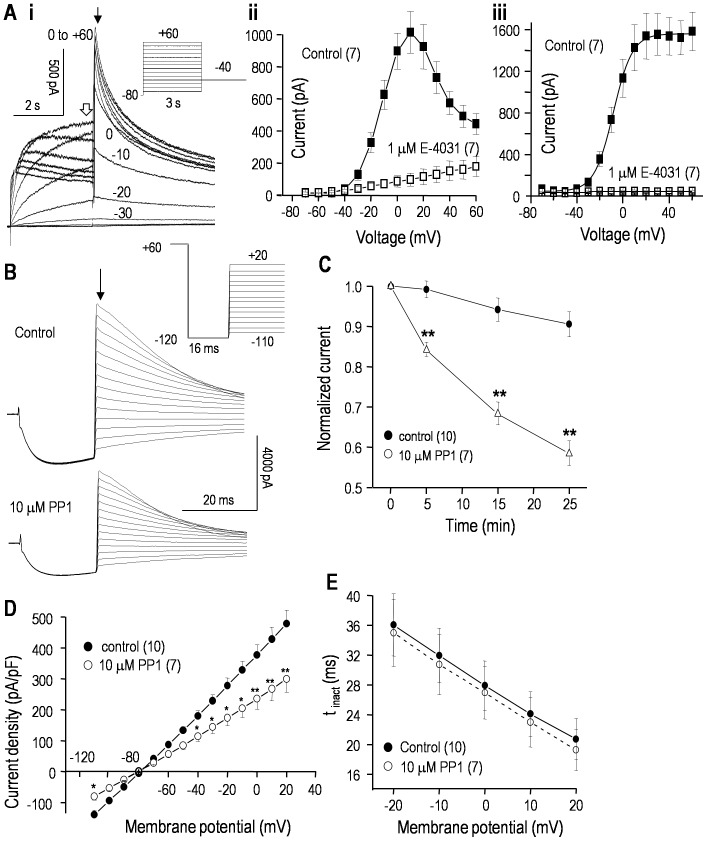
The hERG current in stably transfected HEK293 cells is reduced by the Src-family tyrosine kinase inhibitor, PP1.
A. i. Representative current traces in response to the voltage-clamp protocol shown in the inset. From the holding potential of −80 mV, 3-s long depolarizing steps were applied between −70 and +60 mV (10-mV increments). This opens the channels, but at positive potentials, some inactivation is seen (c→o→i). The voltage was then stepped to −40 mV to remove inactivation (i→o) and monitor outward tail currents. ii. The current amplitude at the end of each 3-sec long depolarizing step (open arrow in Ai) was used to construct a current-versus-voltage (I–V curve) before and after perfusing the hERG blocker, 1 µM E-4031, into the bath. iii. Summary of instantaneous I–V relations from tail currents (closed arrow in Ai) before and after adding E-4031. In all graphs, the values are mean±SEM for the number of cells in parentheses. B. Representative whole-cell currents are shown before and 25 min after adding 10 µM PP1 to the bath. From a holding potential of −80 mV, a 1 s long pulse to +60 mV was used to activate and then inactivate the channels (c→o→i). Then, inactivation was rapidly removed by a 16 ms long pulse to −120 mV (i→o). Instantaneous tail currents (arrow) during test pulses between −110 and +20 mV (10-mV increments) were used to measure the open-channel current-vs-voltage (I–V) relationship (summarized in D) and inactivation kinetics (summarized in E). C. PP1 reduces the hERG current. To monitor time-dependent changes, the instantaneous tail current at +20 mV was repeatedly measured in control cells and in separate cells exposed to 10 µM PP1. Each current was normalized to its initial value (measured at 3–4 min after starting the recording). Significant differences between control and PP1-treated cells are indicated as *p<0.05; **p<0.01. D. Open-channel I–V relations from instantaneous tail currents (as in panel B) were recorded at 25 min in control cells and in separate cells exposed to 10 µM PP1. For each cell, the current was normalized to cell capacitance to yield current density (pA/pF). E. The time constant of inactivation (τ) was measured after 25 min in control cells or with 10 µM PP1 in the bath. That is, for test pulses between +20 and −20 mV, the decay of the tail current (o→i; as in panel B) was fitted to a mono-exponential function: It = AMP*exp(−t/τ), where It is the outward current at time t and AMP is the initial current amplitude. Each fit was begun at the time indicated by the arrow in panel B.